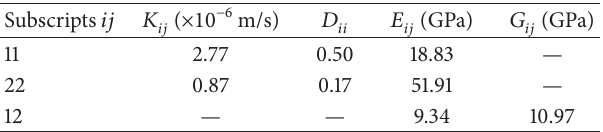
Table 4: The hydraulic conductivity coefficients 𝐾 𝑖𝑗 , damage tensor 𝐷 𝑖𝑖 and Young’s modulus sample along joint plane direction.